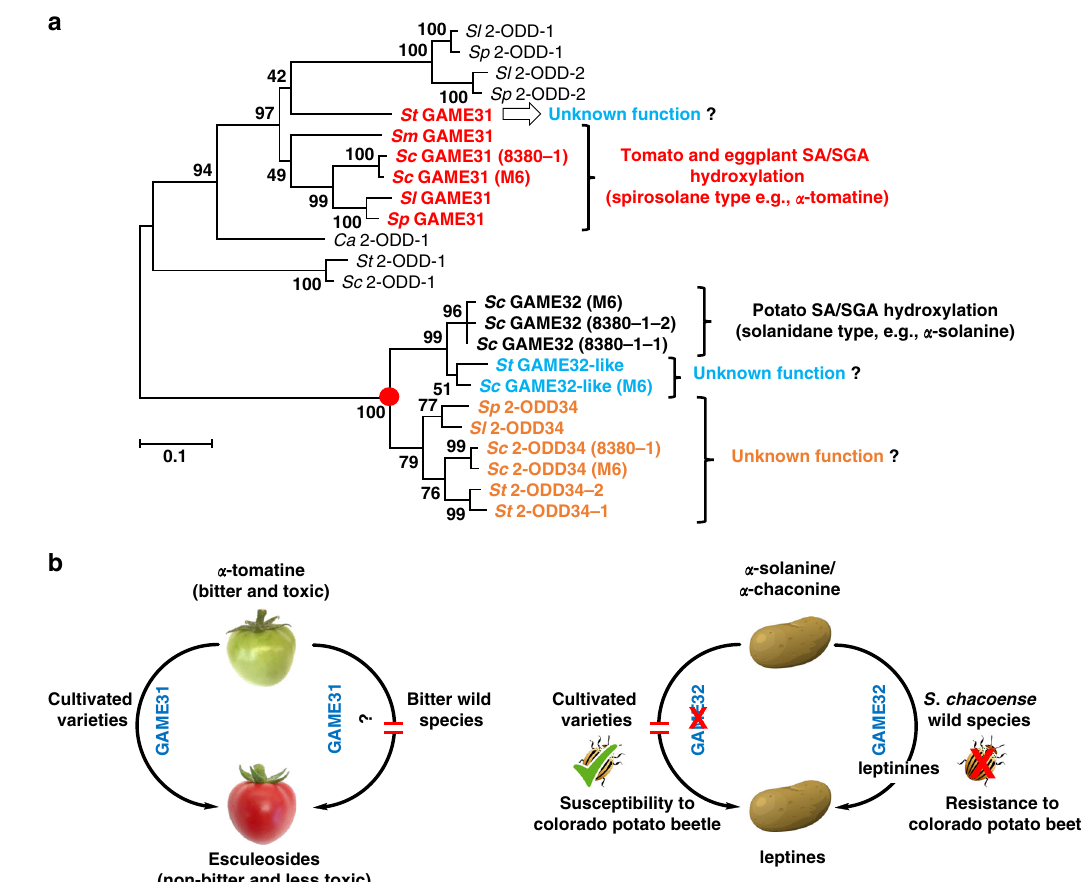
Fig. 7 Pathways to unique defense metabolites and for evading fruit bitterness evolved through 2-ODD activity. a GAME proteins (GAME31 and GAME32) carrying out typical hydroxylation reactions in Solanum SGA metabolism and other putative candidates (GAME32-like and 2-ODD34) form distinct clades in the 2-oxoglutarate-dependent dioxygenase (2-ODD) family. Sequences from the following species were represented: cultivated tomato [ S. lycopersicum , ( Sl )], cultivated potato [ S. tuberosum , ( St )], wild tomato [ S. pennellii , ( Sp )], Capsicum annuum ( Ca ), cultivated eggplant [ S. melongena , ( Sm )], and wild potato [ S. chacoense , ( Sc )]. GAME31, GAME32, GAME32-like, and 2-ODD34 proteins forming separate clades are depicted in red, black, blue, and brown colors, respectively. Amino acid sequences used in the phylogenetic analysis are provided in Supplementary Data 3. Red dot denotes common ancestor shared between GAME32 and 2-ODD34 clade proteins. b A model presenting the impact of GAME31 and GAME32 proteins activity on tomato fruit fl avor (bitter/ sweet) and fruit toxicity as well as resistance of potato plants to CPB insect pest. Activity of GAME31 is required to modulate bitterness and toxicity in ripe tomato fruit. Green tomato fruit accumulates a bitter and toxic α -tomatine SGA. As the fruit matures reaching the red stage, the entire α -tomatine pool is converted to non-bitter and less toxic esculeosides. In cultivated tomato varieties, GAME31 performs the fi rst reaction step (i.e. hydroxylation) that ensures degradation of α -tomatine and results in non-bitter and harmless ripe fruit. On the contrary, red ripe fruit of certain wild tomato species (e.g. S. lycopersicum var. cerasiforme ) are bitter in fl avor due to high accumulation of α -tomatine 7 . These wild species are apparently altered in the process of α -tomatine catabolism. GAME32 activity in S. chacoense wild potato is vital for its genetic resistance against Colorado potato beetle (CPB). Through the action of the GAME32 enzyme, α -chaconine and α -solanine are fi rst converted to leptinines and further to downstream leptines, respectively, in S. chacoense , which makes this wild species naturally resistant to CPB. The leptinine-producing GAME32 gene is absent in the cultivated potato genome, thus